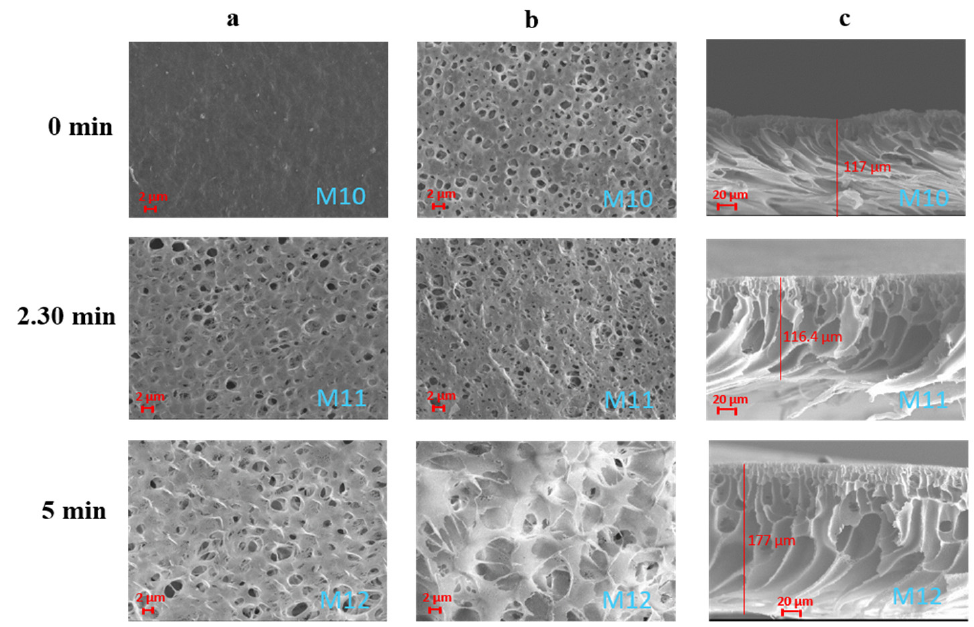
Figure 9. SEM images illustrating the effect of the exposure time to humidity on PVDF-HFP/S-